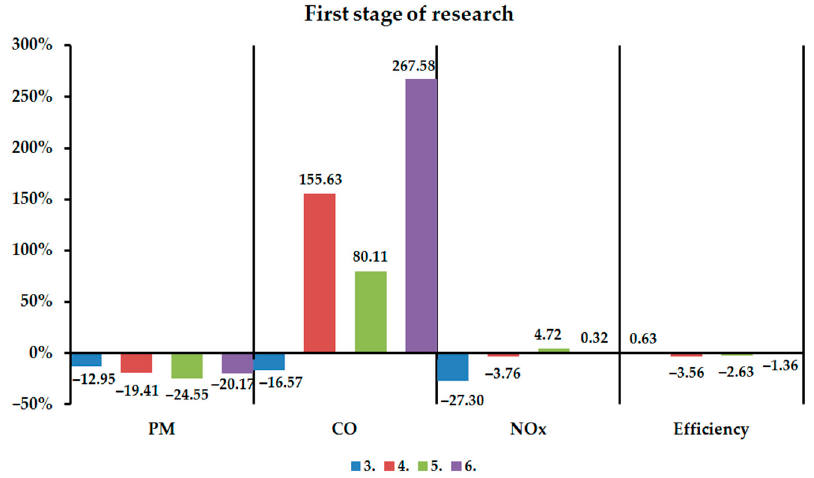
Figure 8. Changes in emission and efficiency parameters of the combustion process obtained for the first stage of research (cycles from 3 to 6).